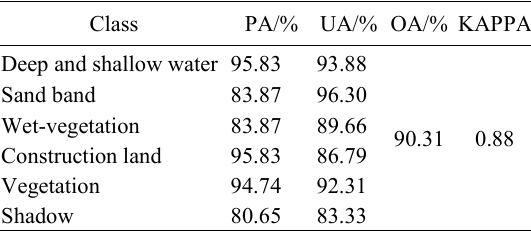
Table 3. The producer’s and user’s accuracies of 2017LandsatOLI wetlands